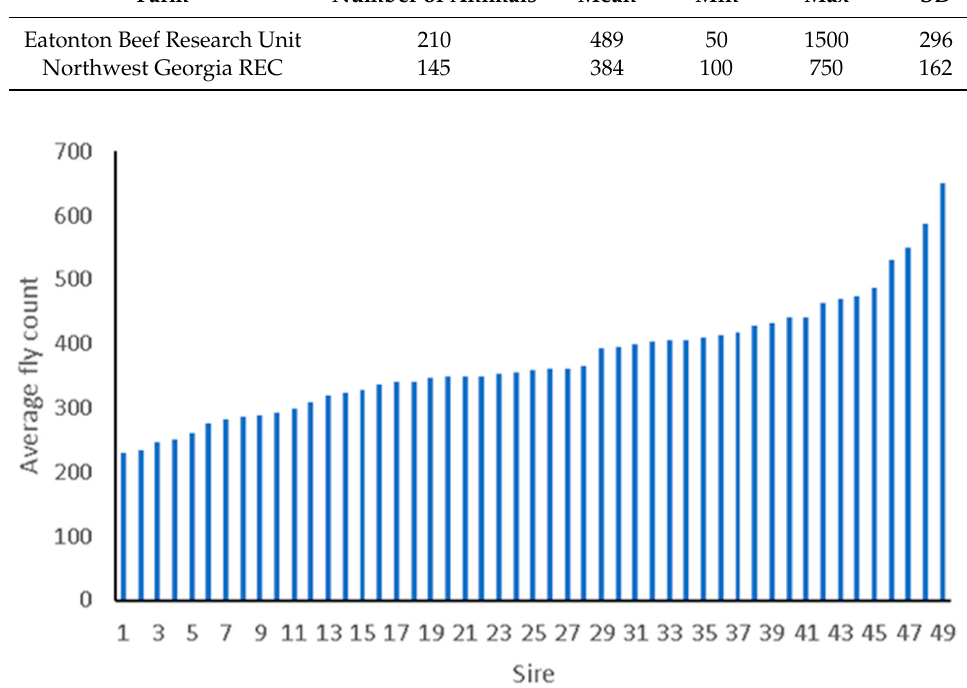
Table 2. Summary description of subjective assessment of horn fly abundance on both farms for both evaluation dates.